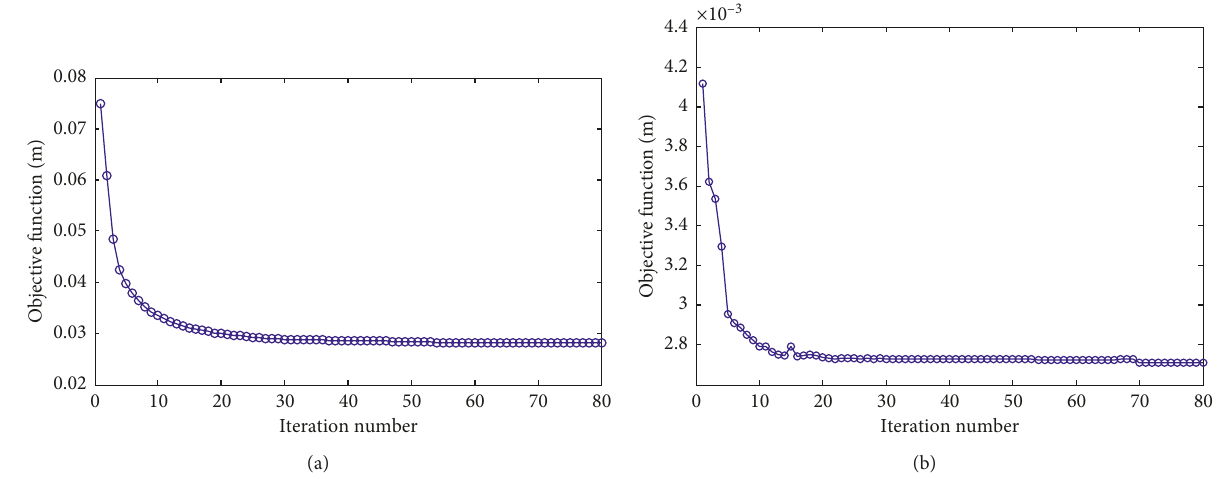
0 , 100 Hz and (b) f 100 , 1000 Hz. (cid:31) [ ] (cid:31) [ ] Values of the objective